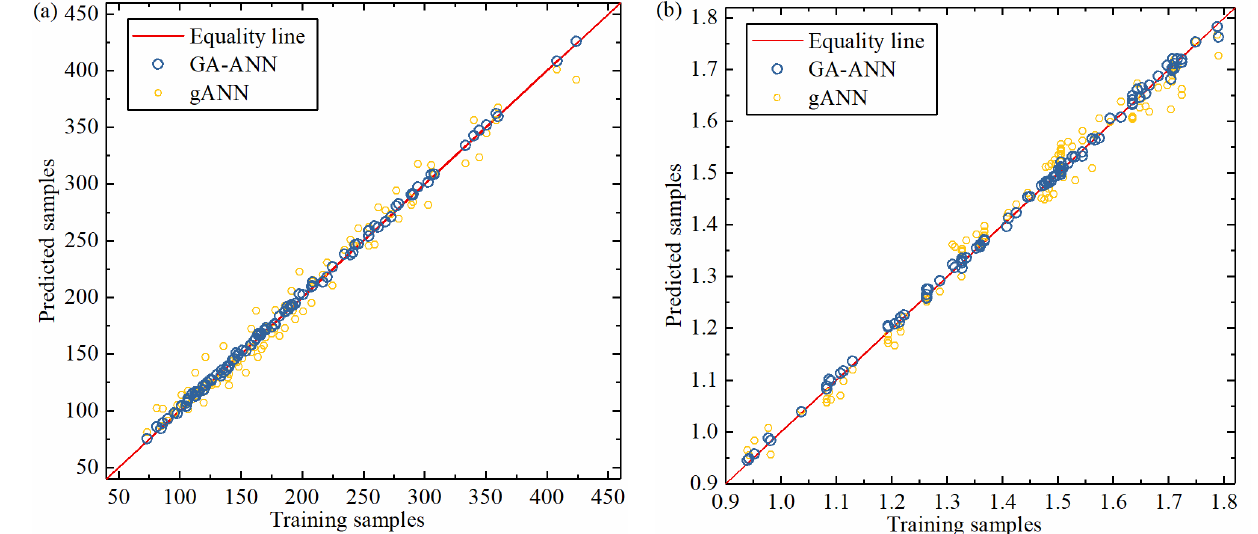
Figure 6. Regression of training dataset: ( a ) capillary force and ( b ) contact diameter.